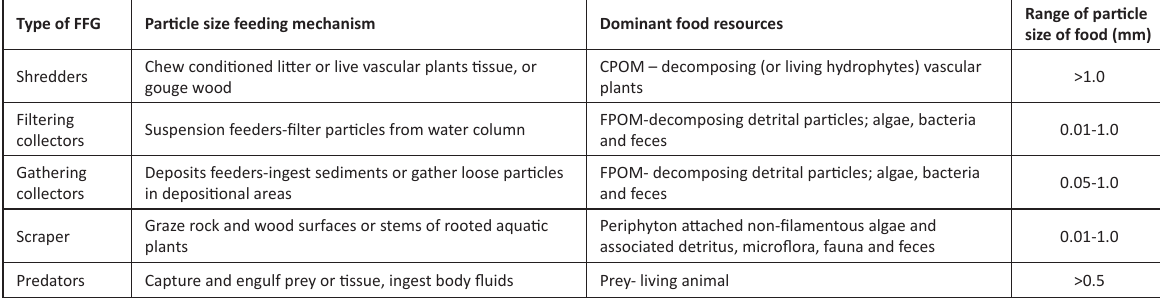
Table 2. Functional group characterization and food resources (from Merritt & Cummis